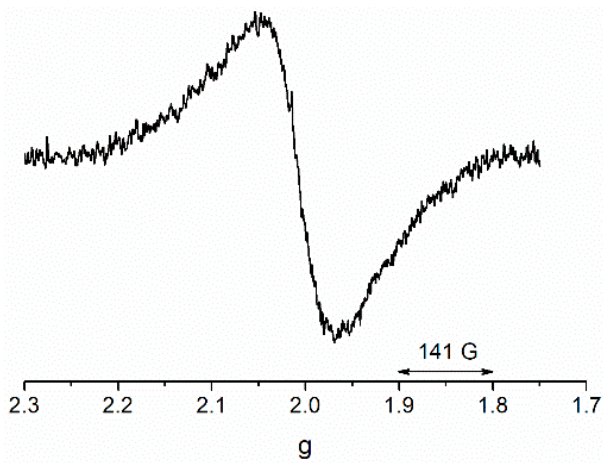
Figure 4. EPR spectrum of sample wAC diluted in KBr at a concentration of 1.7 wt%.